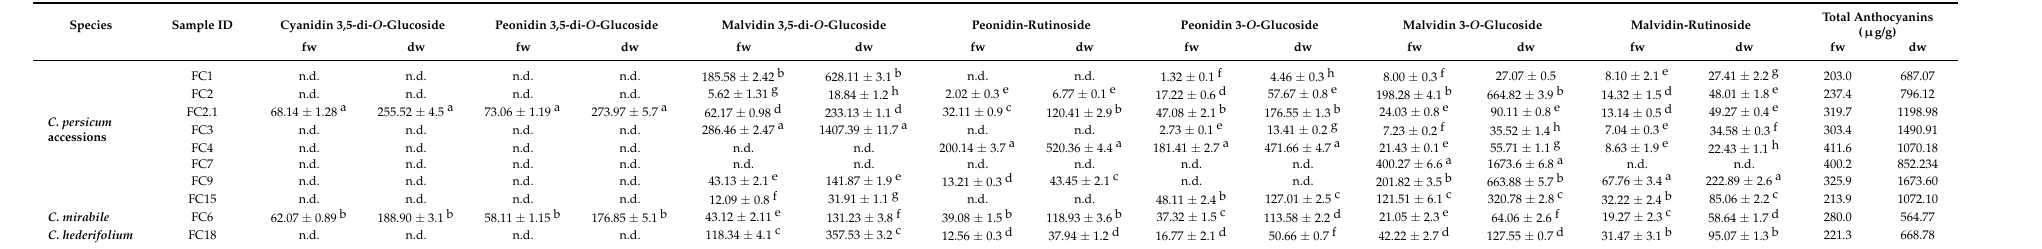
Table 3. Anthocyanin composition ( µ g/g fresh (fw) and dry weight (dw) ± SD) in Cyclamen genotypes